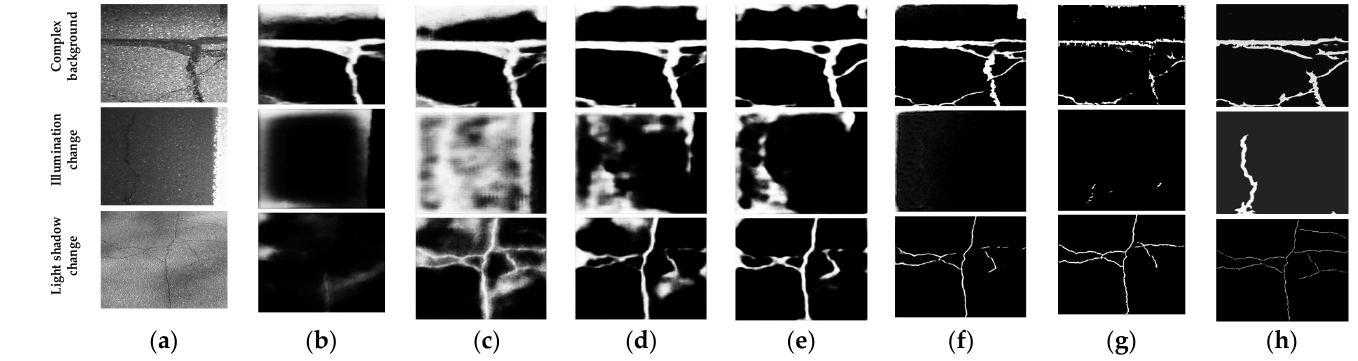
Figure 11. Segmentation comparison results under polarized light: ( a ) original images; ( b ) FCN [40]; ( c ) RCF [41]; ( d ) HED [11]; ( e ) FPHBN [12]; ( f ) DAUNet [18]; ( g ) SPLAC U-Net [23]; ( h ) our method.